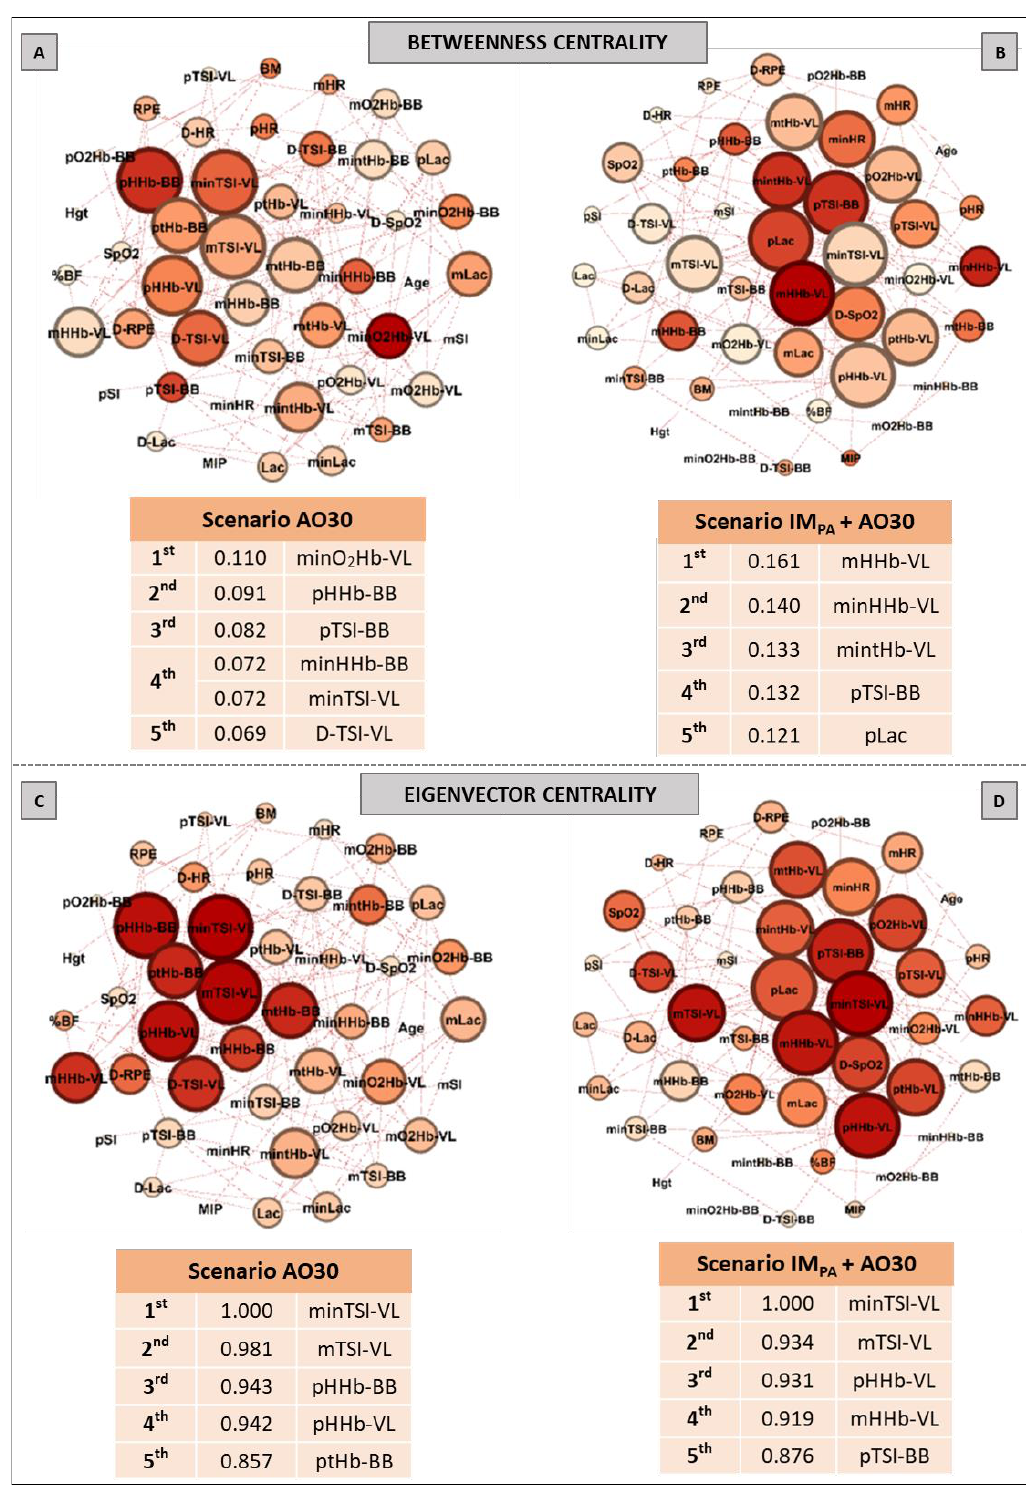
Figure 3. Graphs and top five node results obtained by complex network analysis using Betweenness Centrality ( Panels A,B ) and Eigenvector Centrality metrics ( Panels C,D ) in two exercise scenarios: without inspiratory muscle pre-activation (Scenario AO30, Panels A,C ) and with inspiratory muscle pre-activation (Scenario IM PA + AO30, Panels B,D ). Graph visualizations were done using Gephi software (version 0.9.2, Paris, France). Legend: AO30 = all-out 30 s, IM PA = inspiratory muscle pre-activation, Hgt = height, BM = body mass, %BF = percentage of body fat, MIP = maximal inspir- atory pressure, SI = global strength index of inspiratory muscles, Lac = blood lactate, HR = heart rate, SpO 2 = arterial oxygen saturation, RPE = perceived exertion, O 2 Hb = oxyhemoglobin relative con- centration, HHb = deoxyhemoglobin relative concentration, tHb = total hemoglobin, TSI = tissue